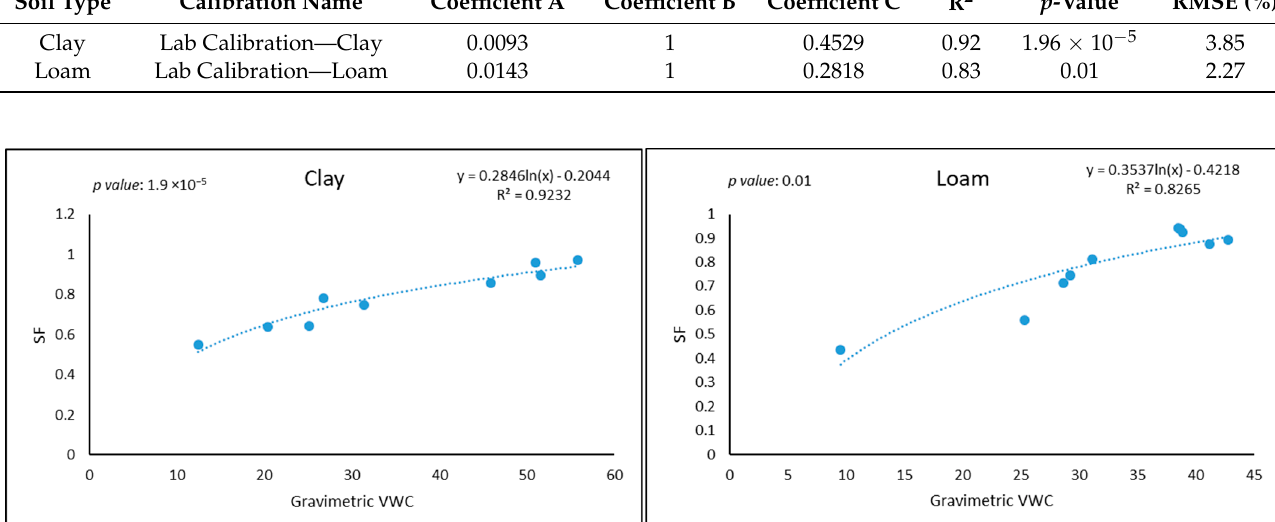
Figure 11. Fitting regression analysis of laboratory calibration.